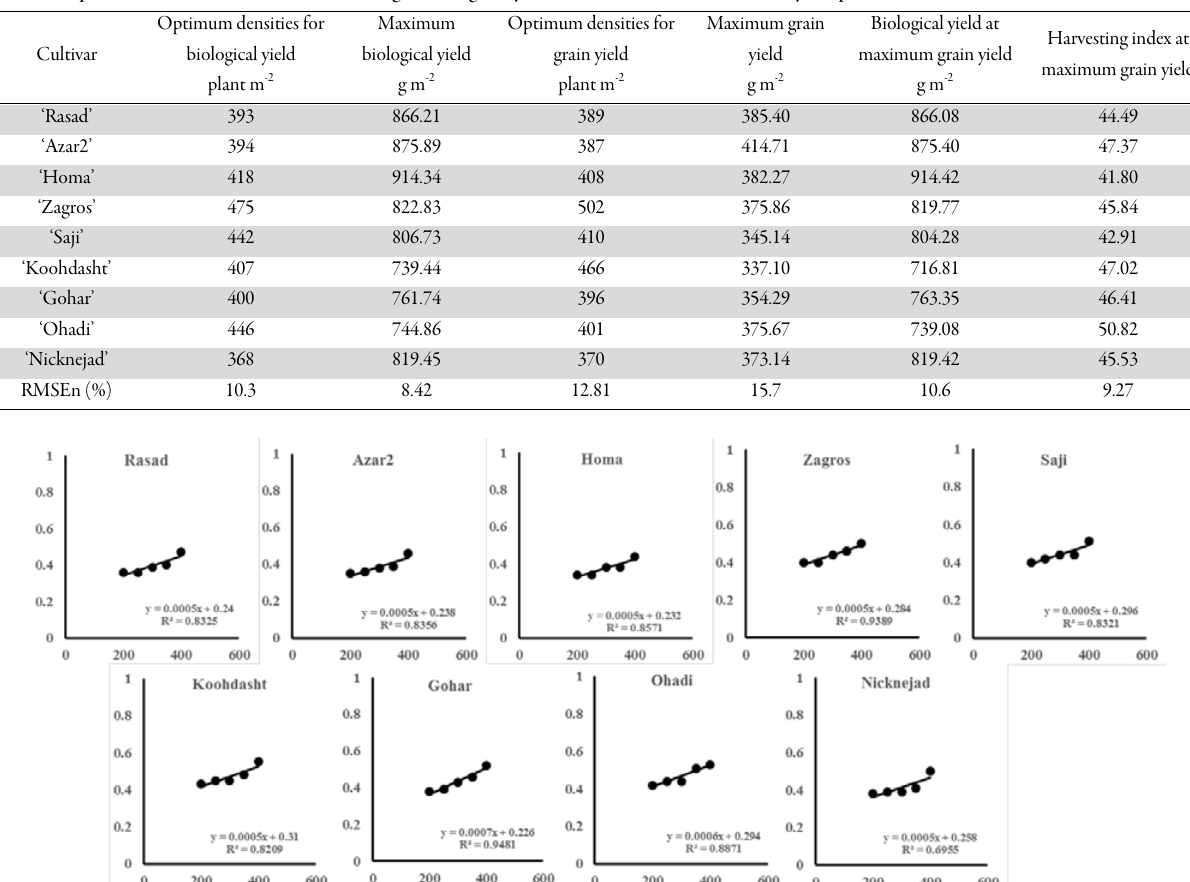
Table 2. Optimum densities and maximum biological and grain yields at different wheat cultivars by reciprocal model Cultivar